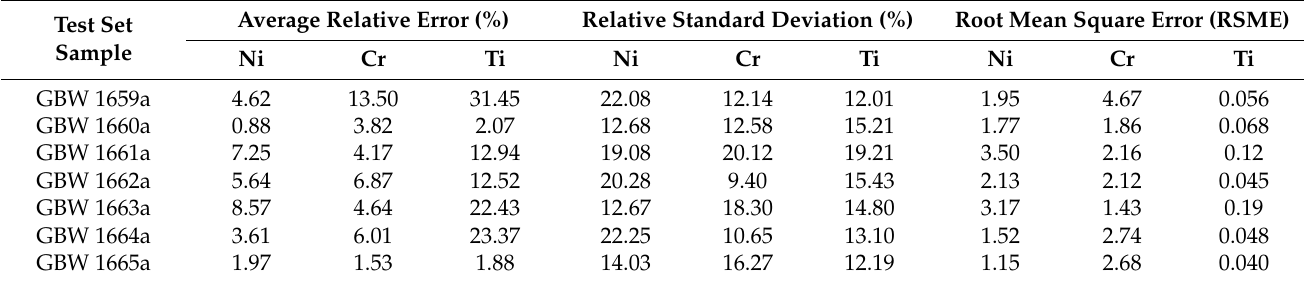
Table 5. Determination result of Ni, Cr, and Ti with BP-ANN (Group 1).